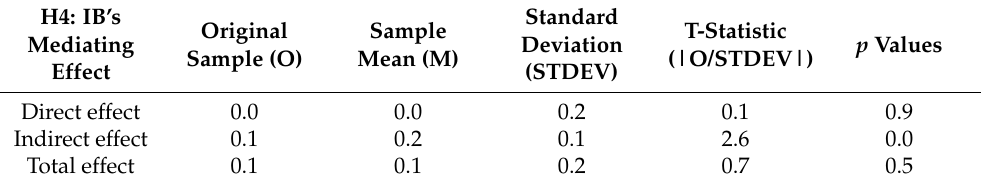
Table 4. Mediating Effect.